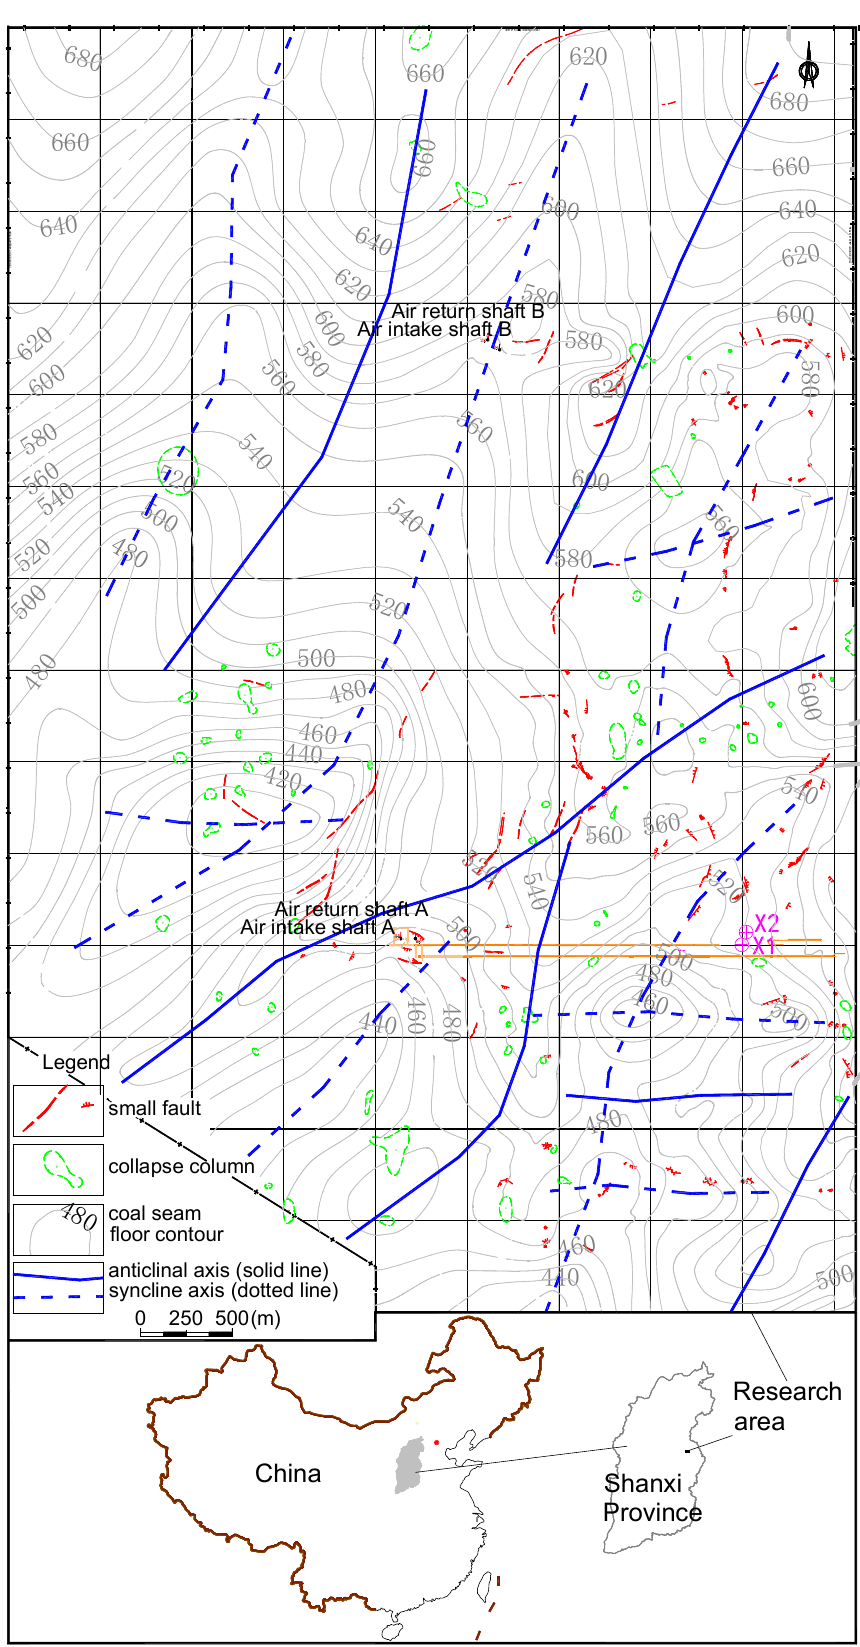
Figure 1. The structural features and geographical position of the research area.